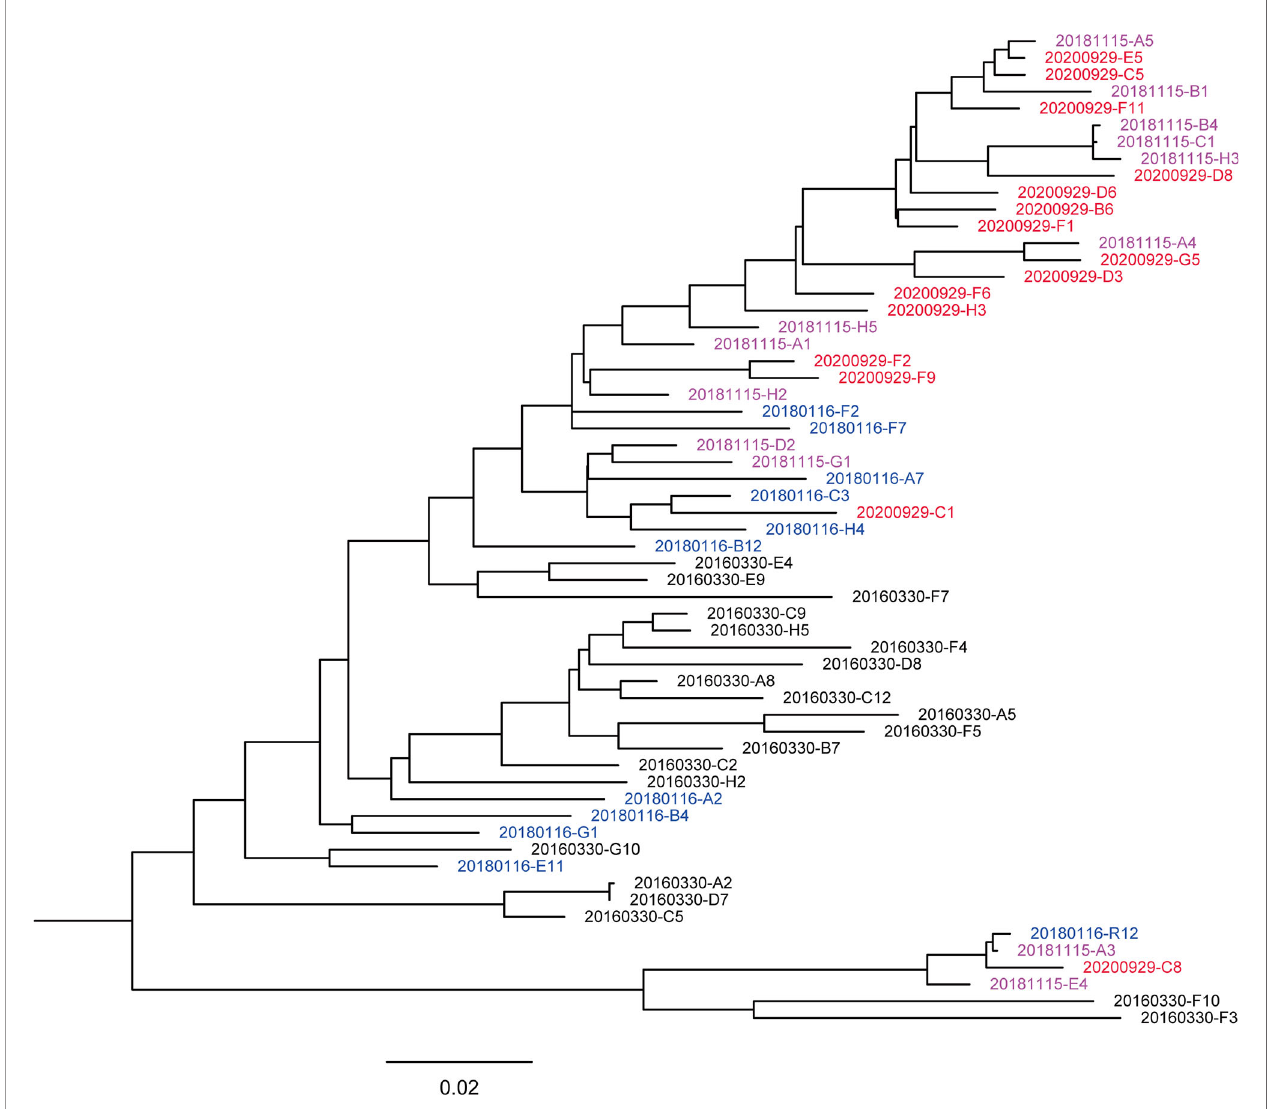
FIGURE 1 | Maximum likelihood method-based phylogenetic tree of the env genes. A total of 59 nearly full-length Env sequences from the donor. The phylogenetic tree was inferred with IQtree v1.6.1 and visualized with FigTree. Tree showed that the sequences intermingled, crossing different time points. The sequences from different sampling time points are highlighted in black (201603), blue (201801), purple-pink (201811), and red (202009), respectively. The bar under the phylogenetic tree is the genetic distance